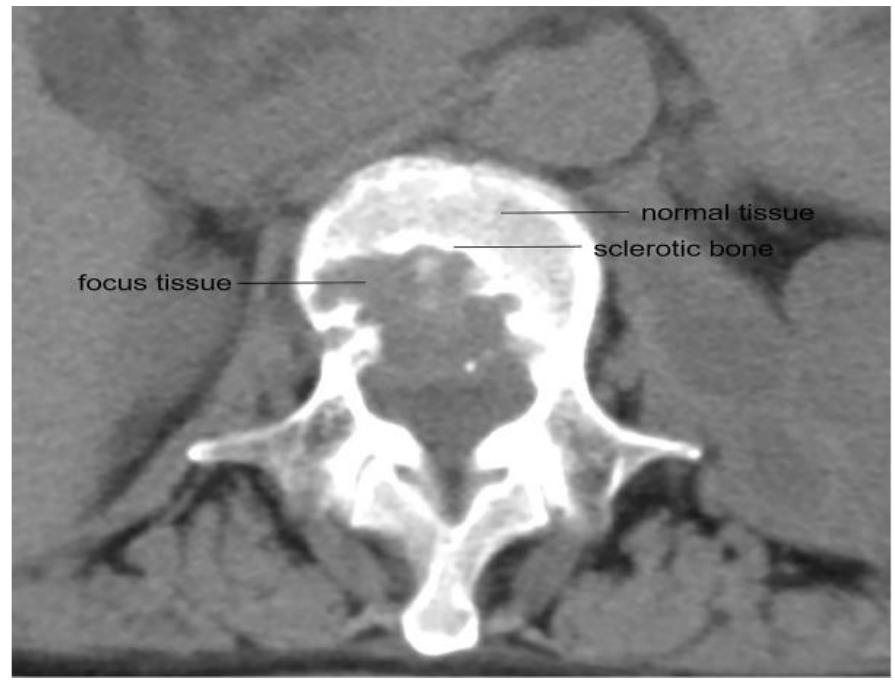
Figure 1. CT scan showing the location of healthy bone tissue and the focus tissue in a vertebra. The venous blood samples were centrifuged at 5000 rpm for 15 min to obtain the plasma for further determinations. The normal vertebral bone tissue and vertebral focus tissue were washed with saline and dried with a paper tissue before being weighed in the laboratory. The above-mentioned tissues from the vertebrae were cryodesiccated and pulverized into a fine powder using liquid-nitrogen-combined grinding. A powder of 200 µ g was mixed with 2 mL of an extract of dimethylcarbinol-dichloromethane (1:1) and centrifuged for 15 min successively, and the supernatant was collected. The processing time of the plasma and supernatant samples was 30 min and 45 min, respectively. All of the samples were all stored at − 80 ◦